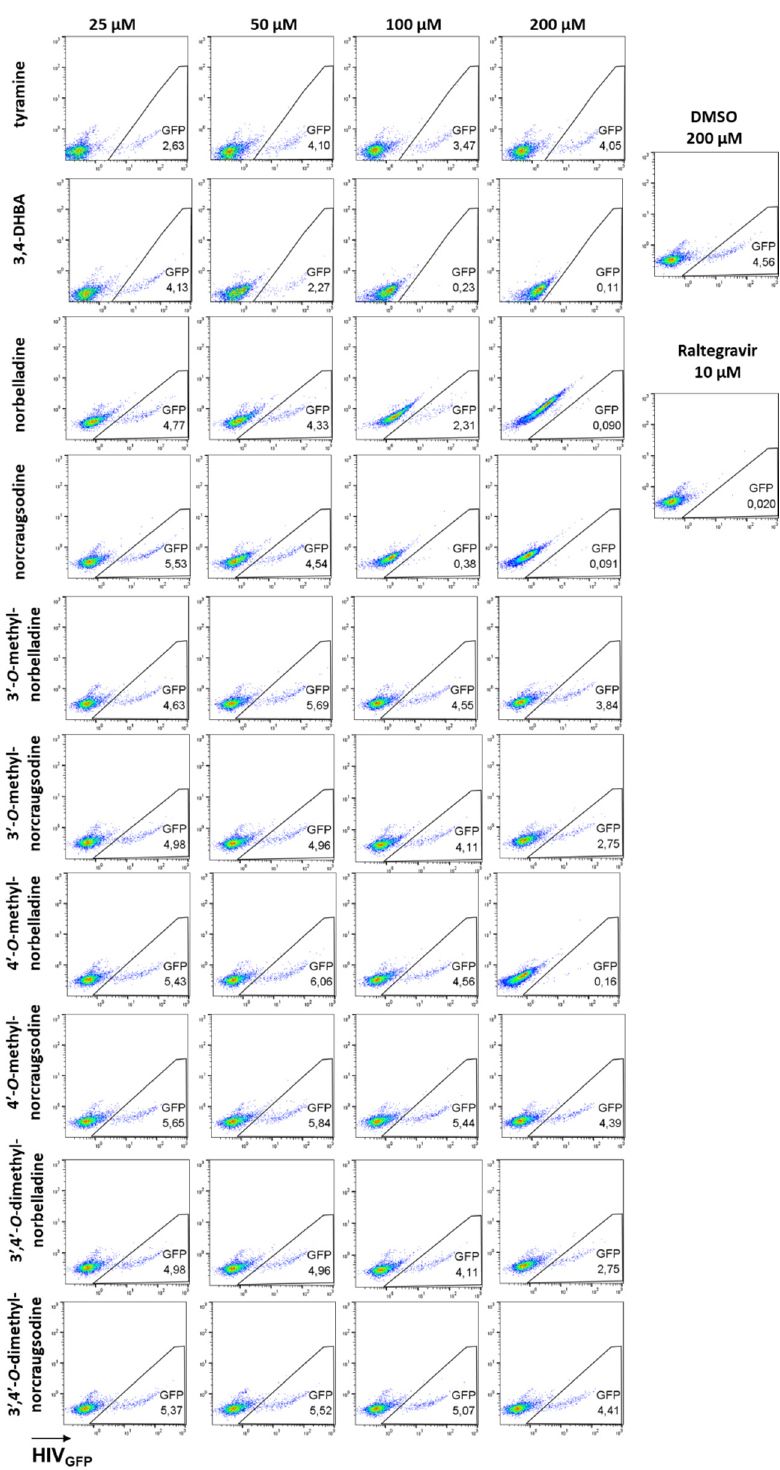
Figure A1. Antiretroviral effects of four concentrations (25, 50, 100, and 200 µ M) of norbelladine precursors and derivatives on HIV-1 GFP in THP1 cells. Representative dot plots are presented. DMSO (200 μ M) and raltegravir (10 μ M) were included as the negative and positive controls, re- spectively.